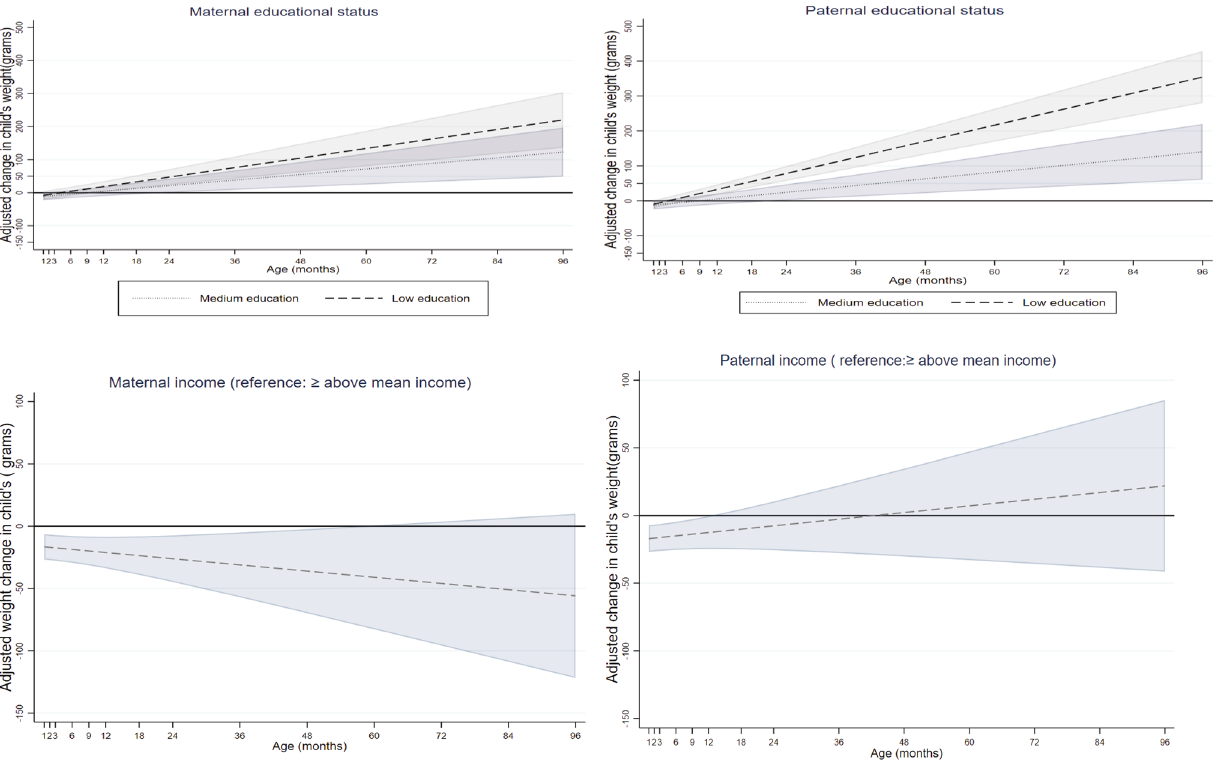
Figure 1. Associations between maternal and paternal education and income with children’s weight in grams from 1 month to 8 year (β coefficients in dash and dot lines and 95% CIs in solid Paternal educational level was inversely associated with children’s weight from the age of 9 months onwards (Fig. 1). Children of low educated fathers on average weighed more from the age of 9 months onwards compared to their peers with high-educated fathers (e.g. weighed; 21.1 g more (95% CI 8.0, 34.1 g) at the age of 9 months and 354.1 g more (95% CI 279.8, 428.4 g) at 8 years). Children of fathers with medium educational level on aver- age weighed more from the age of 2 years to 8 years compared to their peers with high educated-fathers (Fig. 1, Supplementary Table S4). Maternal income was positively associated with children’s weight from the age of 1 month up to 4 years (Fig. 1). Children of mothers who earned below mean income on average weighed less from the age of 1 month up to 4 years, compared to their peers with mothers who earned greater than/equal to mean income (e.g. weighed 16.6 g less (95% CI − 26.8, − 6.4) and 36.1 g less (95% CI − 69.8, − 2.3 g) at the age of 1 month and 4 years, respectively). This association was not present from the age of 5 years onwards (Fig. 1, Supplementary Table S4). Paternal income was positively associated with children’s weight from 1 month to 1 year; after 1 year, the paternal income gradient in children’s weight was no longer significant (Fig. 1). Children of fathers who earned below mean income on average weighed less from the age of 1 month to 1 year, compared to their peers with fathers who earned greater than/equal to mean income (e.g. weighed 17.1 g less (95% CI − 26.9, − 7.2 g) at the age of 1 month and 12.5 g less 95% CI − 24.7, − 0.3 g) at 1 year age) (Fig. 1, Supplementary Table S4). Children of low educated mothers on average had higher weight gain velocity from the age of 18 months to 6 years compared to their peers with high-educated mothers (e.g. gain 1.8 g/month more (95% CI 0.1, 3.5 g/ month) at the age of 18 months and 2.5 g/month more (95% CI 0.0, 4.8 g/month) at age 6 years). No association was observed up to 18 months and after 7 years. Children of low educated fathers on average had higher weight